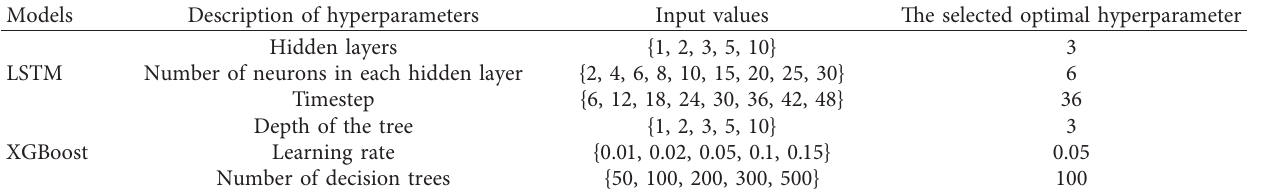
Table 2: Selection of hyperparameters in the model.